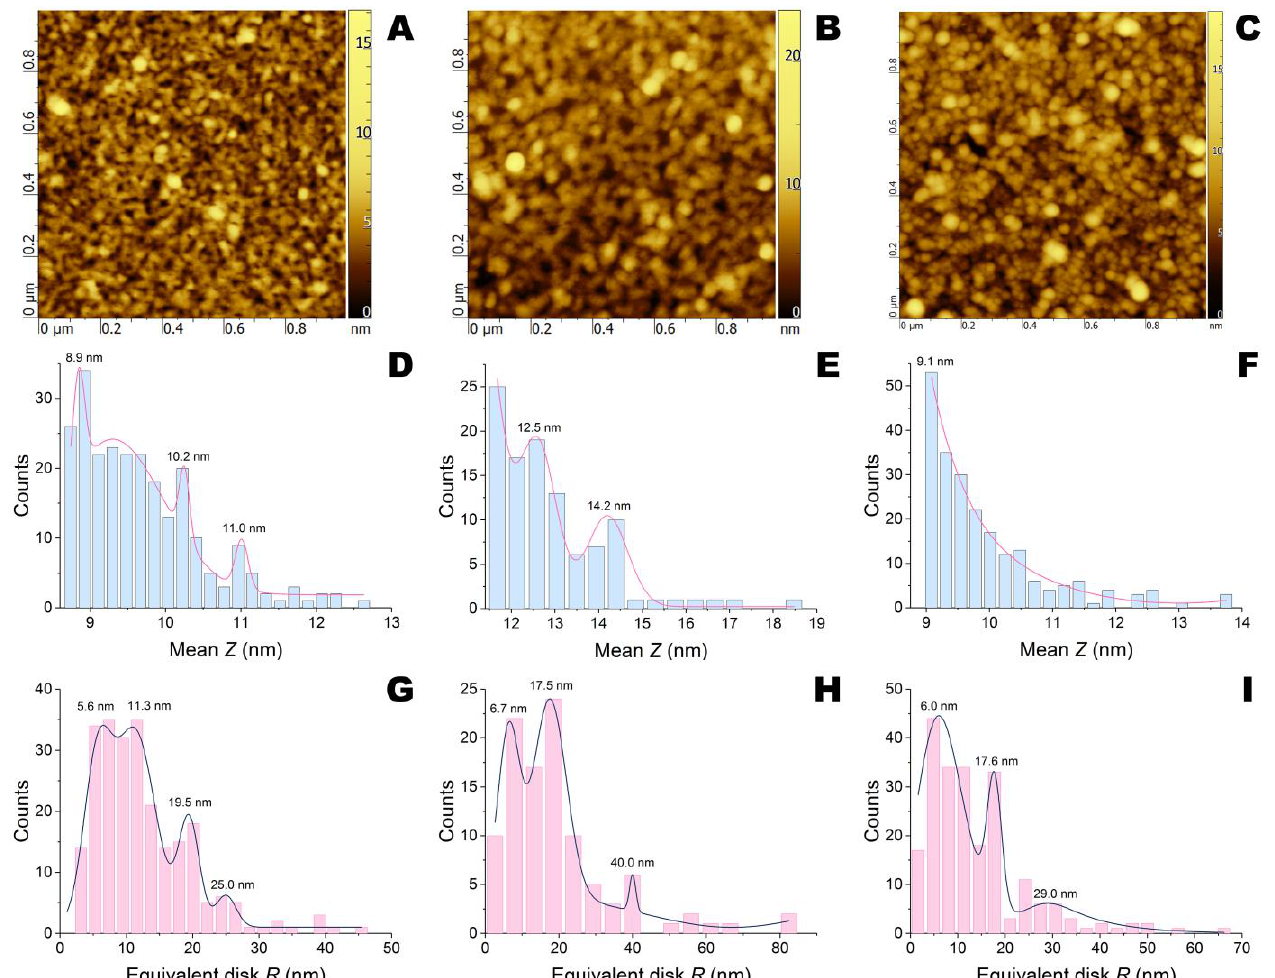
Figure 5. AFM images and their statistical treatment for APS-modified silicon wafers after appli- cation of His 6 -OPH/PLE 50 without QS effectors ( A , D , G ) and with emodin ( B , E , H ) or naringenin ( C , F , I ).